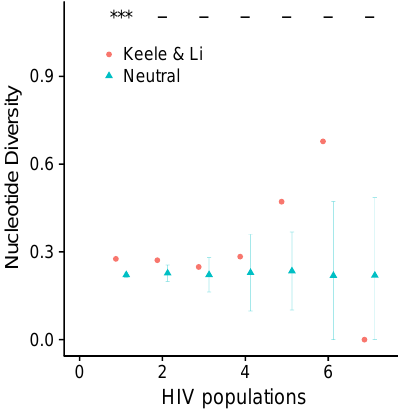
Figure 4. Private mutations occur in positions of high nucleotide diversity. The figure shows the nucleotide diversity (mean and standard deviation) at nucleotide positions, for which Keele and Li mutations were identified (orange) as well as the positions for 1000 individual random mutation distributions (turquois). The positions of the same number of mutations we observe in N HIV-1 populations was randomized in the neutral model. The diversity was determined at each position in